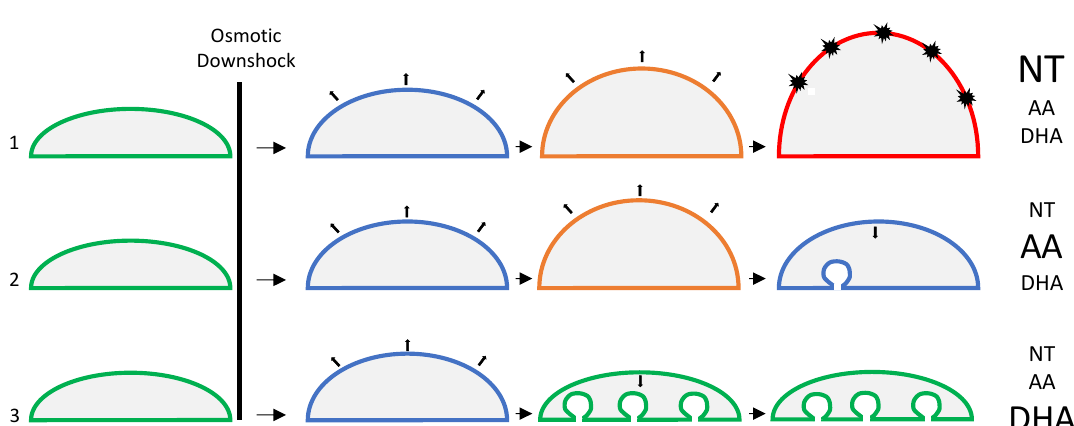
Figure 7. Summary of the sequence of events leading to cell resistance to breakage in response to osmotic downshock. ( A ) Schematic and recapitulative time sequences of surface increase (blue) and VLD formation (green) in NT C2C12 displaying VLDs, NT cracked C2C12 without VLDs, and C2C12 cultivated in media supplemented with either AA or DHA. Time sequence of breakage is also reported (red) for the NT cracked cells. Black bars are positioned at the time values for t surface max and t Vmax for VLDs and are extracted from data in Figures 5 and Figure 6. ( B ) C2C12 cells may experience three different scenarios following osmotic downshock depending on their membrane composition. 1: membrane tension increases pro- gressively until breakage (dark explosions), frequently observed in NT cells. 2: When membrane tension reaches a certain threshold (very high), some VLDs form at the basal membrane level, allowing the reduction of membrane tension, fre- quently observed in AA-treated cells. 3: In a scenario particularly encountered in DHA-treated cells, many VLDs are form- ing, leading to very low membrane tension, a process that avoids cell breakage. As shown, if both PUFA AA and DHA proved to be efficient in reducing cell break- age under osmotic shock (Figure 6C), they clearly promoted different cell behaviors in response to cell swelling. DHA accelerated the obtention of the maximal cell surface (t Surface max ), the time of initiation (t0 VLD), and the rate of VLDs formation (Vmax) and, fi- nally, increased the overall number of VLDs per cell. AA displayed an intermediate be- havior between the NT and DHA conditions. Interestingly, in the NT myoblast unable to form VLDs, cell breakage (Figure 6H) was observed at a time following osmotic shock posterior to the time when AA and DHA myoblasts started to form these structures (Fig- ure 6G; recapitulated in Figure 7A). These data are schematized in Figure 7B.